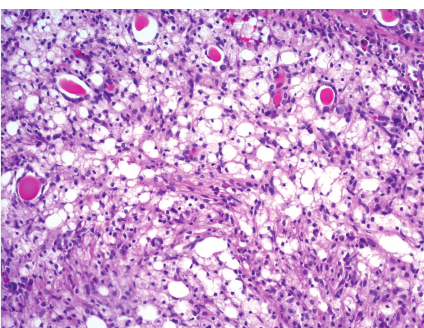
F 3: Microscopic �ndings of the le kidney revealed in�ltra- tion of lymphocytes and lipid-laden macrophages (xanthoma